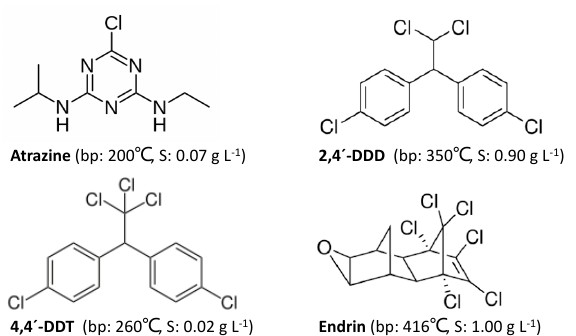
Figure 1. Chemical structures and physical constants (bp: boiling point; S: solubility in water) of the pesticides investigated in this study.